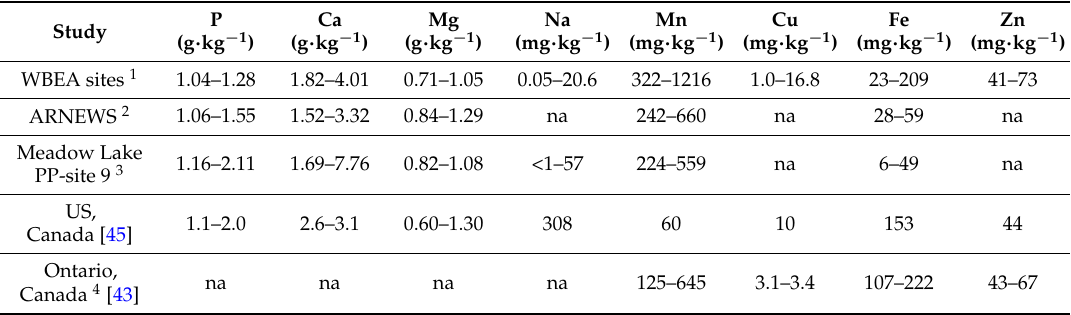
Table 3. Range of nutrient concentrations of current jack pine foliage and comparison with other studies in Western Canada, Ontario and the